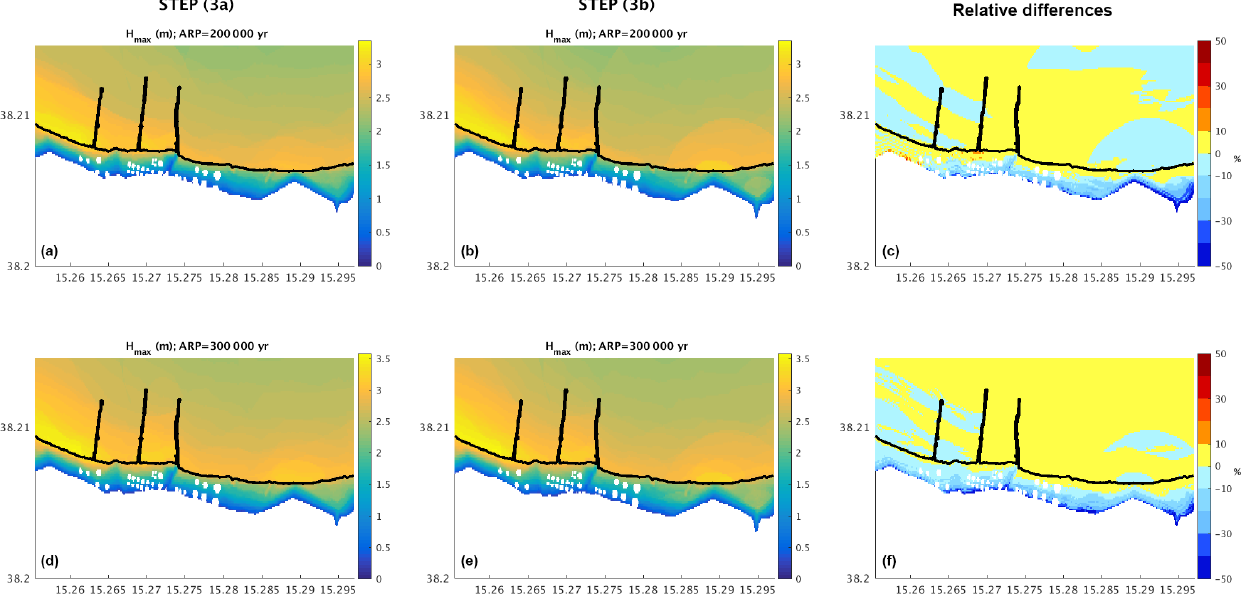
Figure 5. Hazard maps (inner grid; see text) for H max derived from the hazard curves in Fig. 3 at two different ARPs (2 × 10 5 yr, 3 × 10 5 yr) for steps (3a) and (3b) and relative differences, which are computed as follows: [ ( 3a ) − ( 3b ) ] /( 3b )